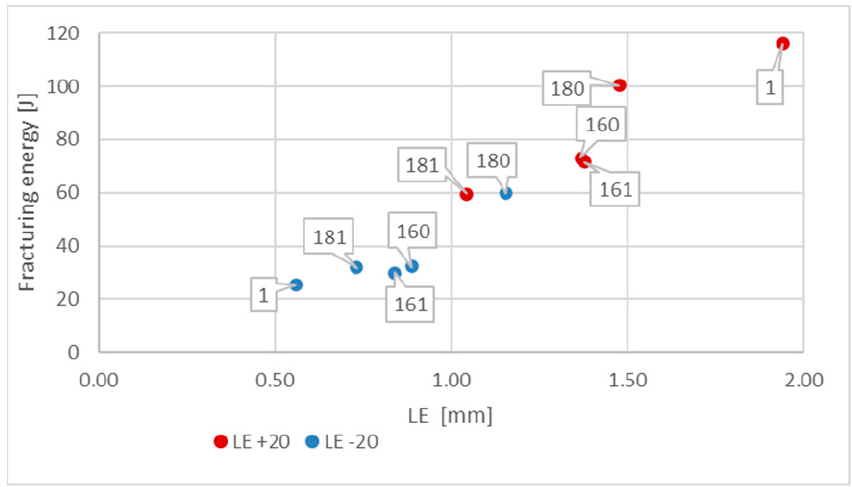
Figure 13. Relationship between averaged values of LE parameter and related values of fracturing energy W t obtained for S355J2+N steel at di ff erent testing conditions.